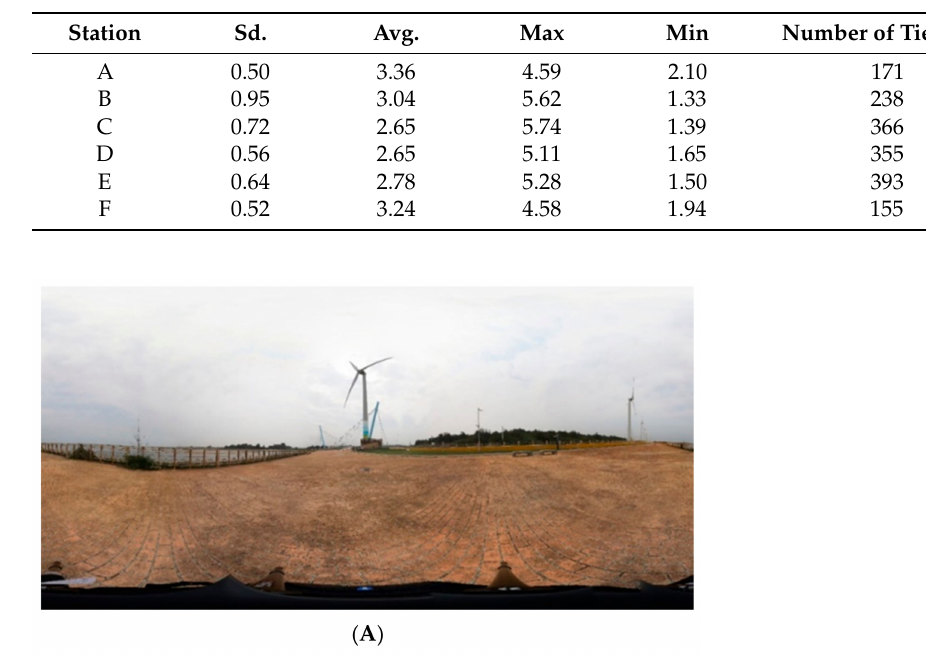
Figure 7. Locations of panoramic stations (points indicate panoramic stations, and the green symbol represents user’s current field of view). Table 4. Statistics of RMSEs with different stations (unit: pixel).